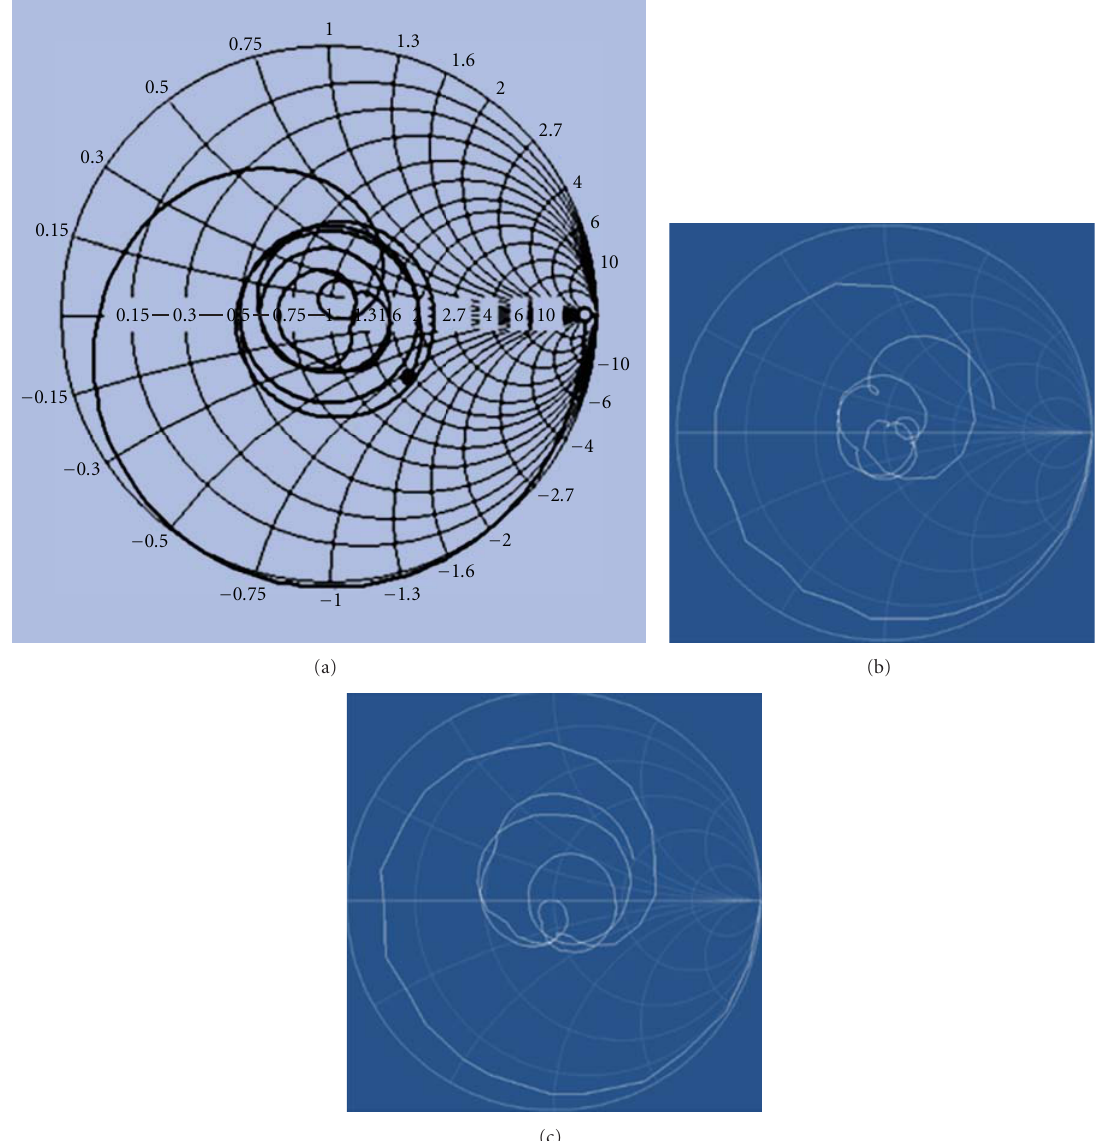
Figure 5: Comparison between simulated and measured results of the input impedance locus using smith chart. (a) Simulated antenna using copper conducting sheet, (b) measured results of copper conducting sheet, and (c) measured results of Shieldit conducting